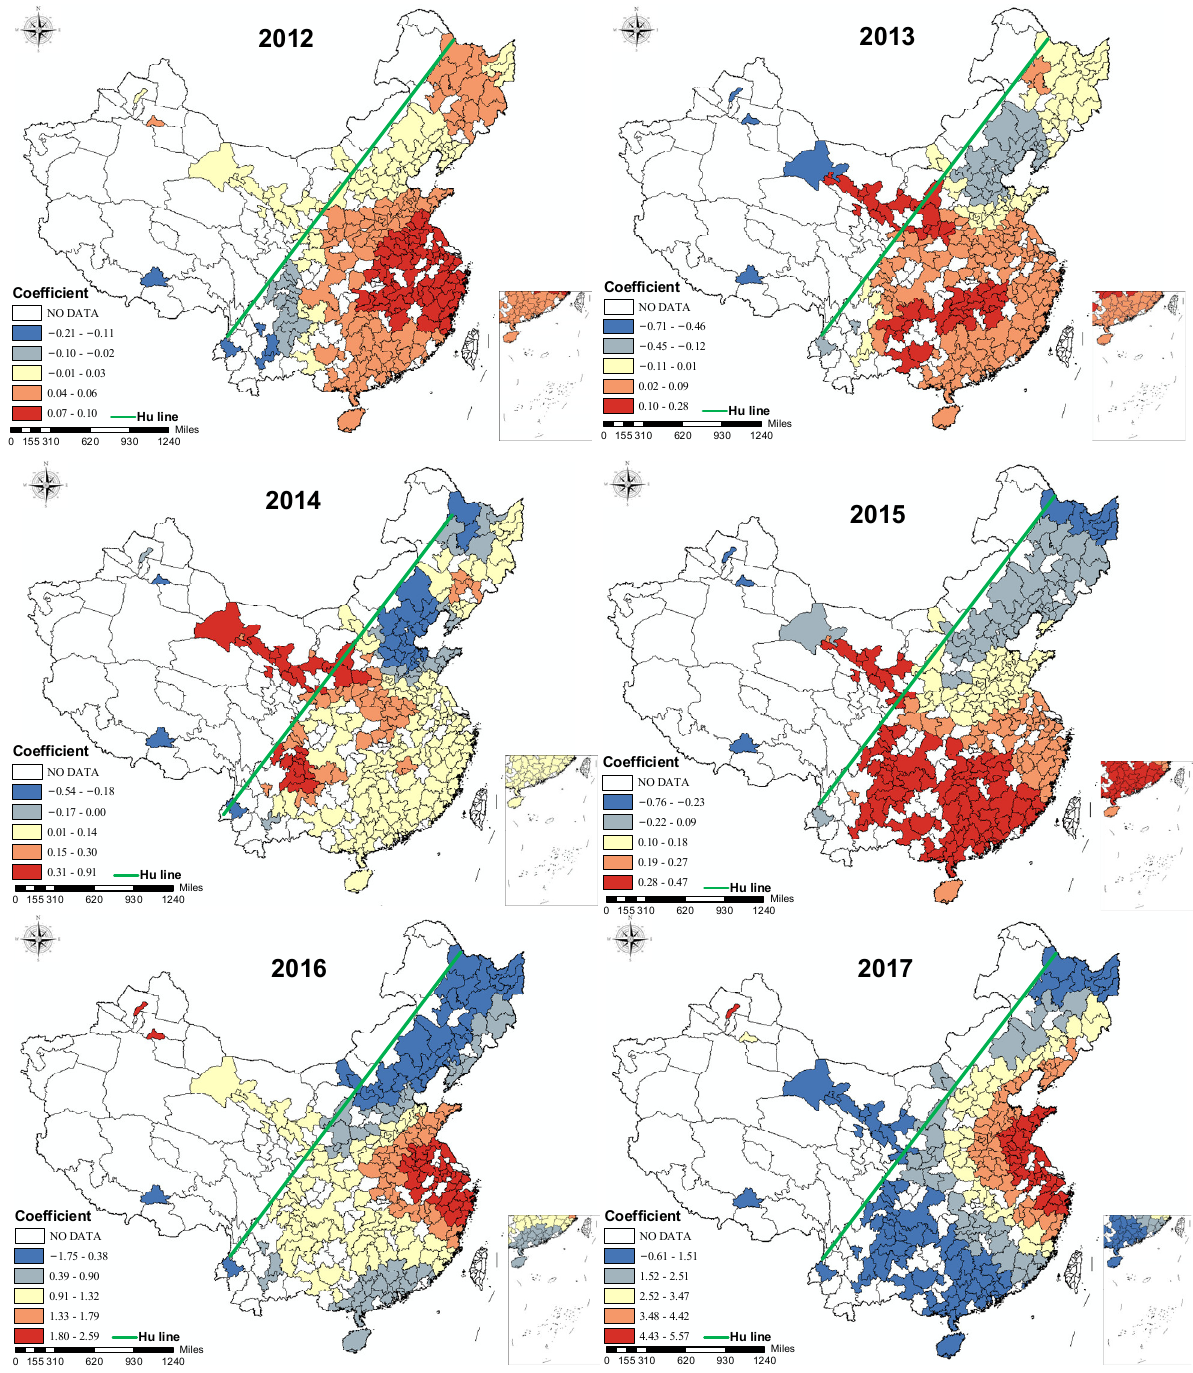
Figure 7. The spatial coefficient distribution for manufacturing practitioners from 2012 to 2017 based on the GWR model. (Note: A positive coefficient indicates a positive association between an increasing proportion of manufacturing practitioners (N_MP) and more inferiority, while a negative coefficient indicates the opposite.)